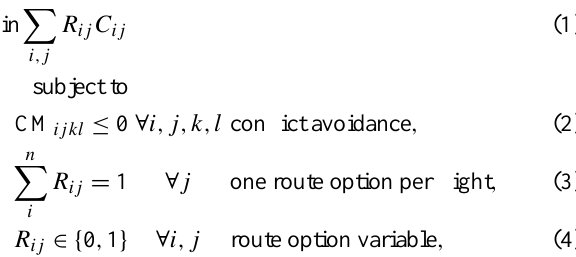
Fig. 5. Properties of an individual Lagrangian air parcel (trajectory) in the submodel AIRTRAC. The possibility to calculate numerous time-region grid point emissions in one simulation is a key aspect for computationally efficient